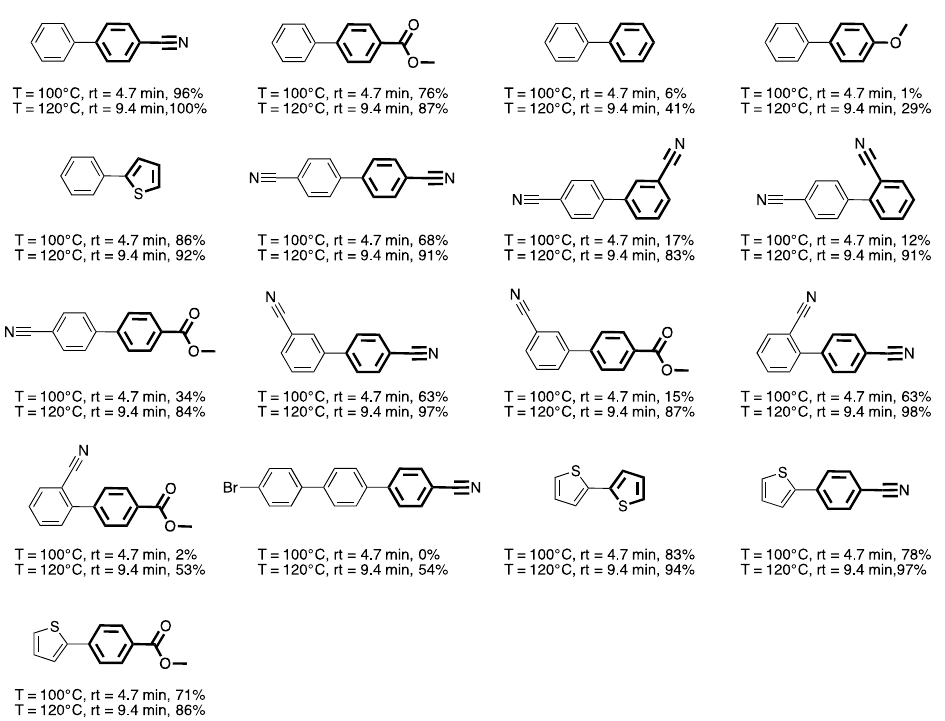
Figure 4. Substrate scope of continuous flow lithiation/borylation/Suzuki–Miyaura cross-coupling sequence in a flow system using immobilized Pd on polymer monolith.